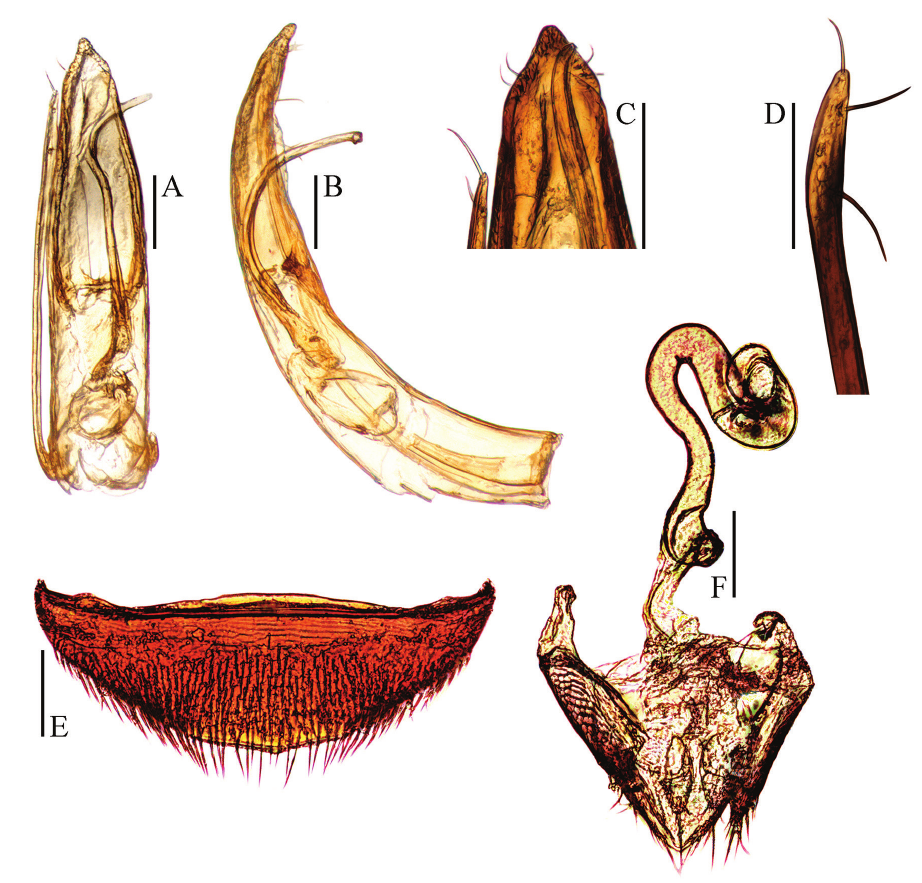
Figure 3. Ptomaphagus (s. str.) nepalensis Perreau, 1988 ( ♂ : paratype; ♀ : paratype). A aedeagus (dorsal view) B aedeagus (lateral view) C aedeagal apex (dorsal view) D paramere apex (lateral view) E ventrite VIII ♀ (ventral view) F spermatheca, genital segment and ovipositor (ventral view). Scale bars: 0.1 mm.